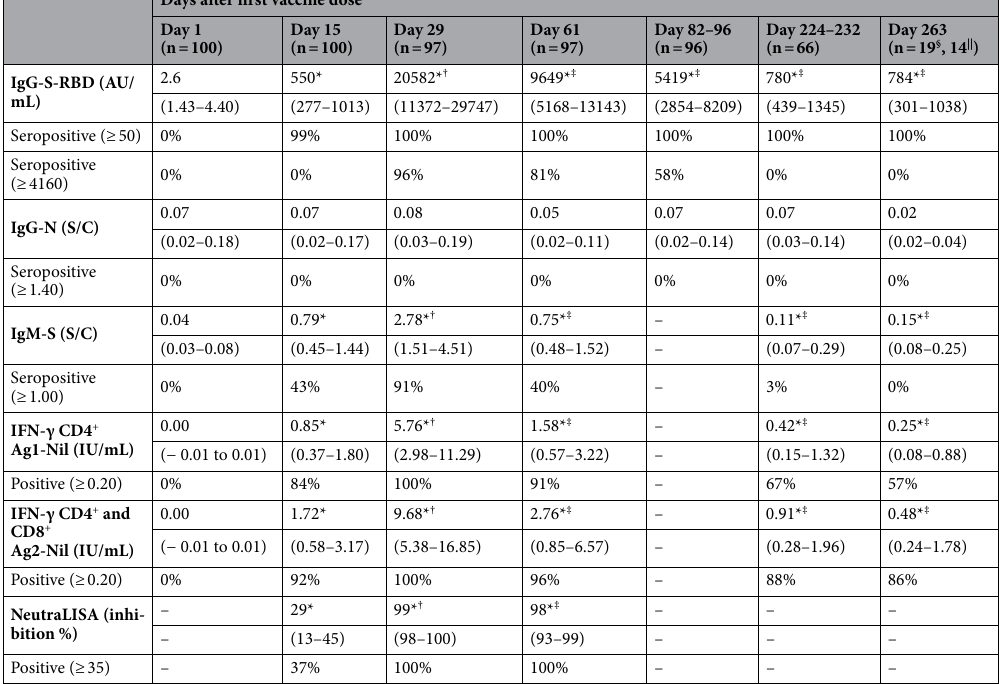
Table 2. Humoral and cellular immune responses during and after BNT162b2 mRNA-based SARS-CoV-2 vaccination regimen. Data are shown as median (interquartile range). * P < 0.01 (Day 1 vs Day 15, 29, 61, 82–96, 224–232, or 263). † P < 0.01 (Day 15 vs Day 29). ‡ P < 0.01 (Day 29 vs Day 61, 82–96, 224–232, or 263). § The number of participants tested for humoral responses (IgG-S-RBD, IgG-N, and IgM-S). || The number of participants tested for T cell responses (Ag1-Nil and